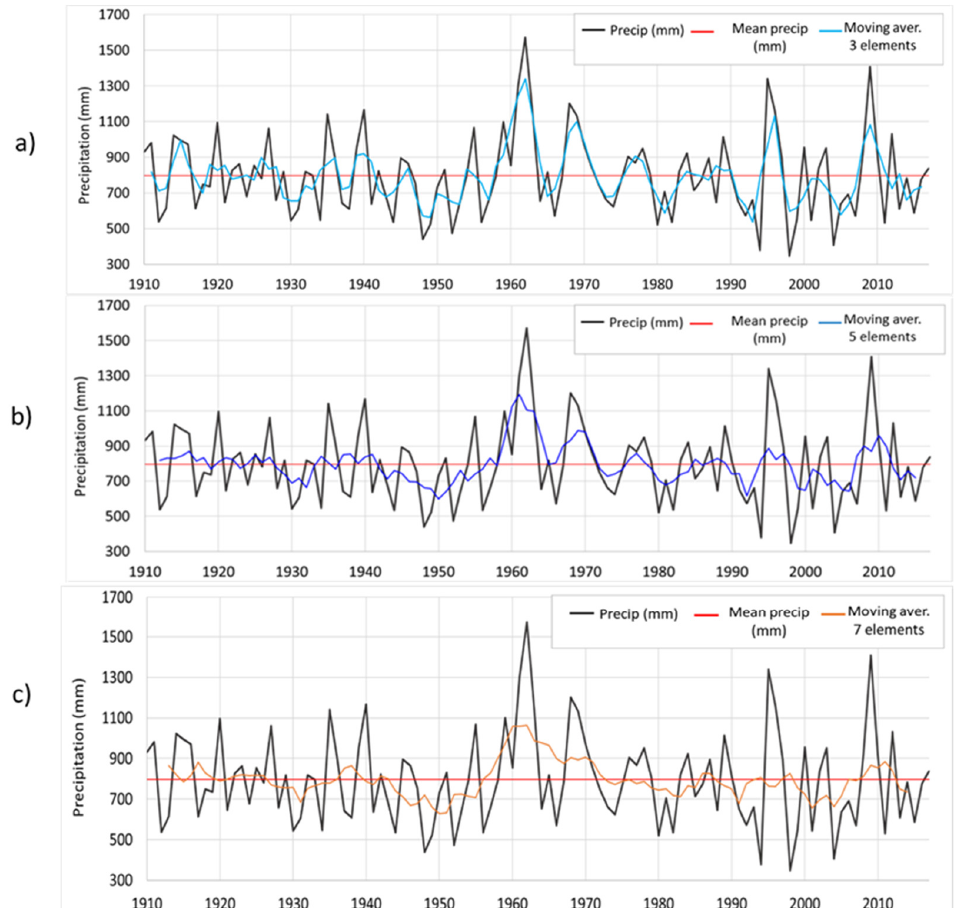
Figure 6. Moving averages of 3 ( a ), 5 ( b ), and 7 ( c ) elements applied to the mean annual precipitation series of the Barbate River basin.